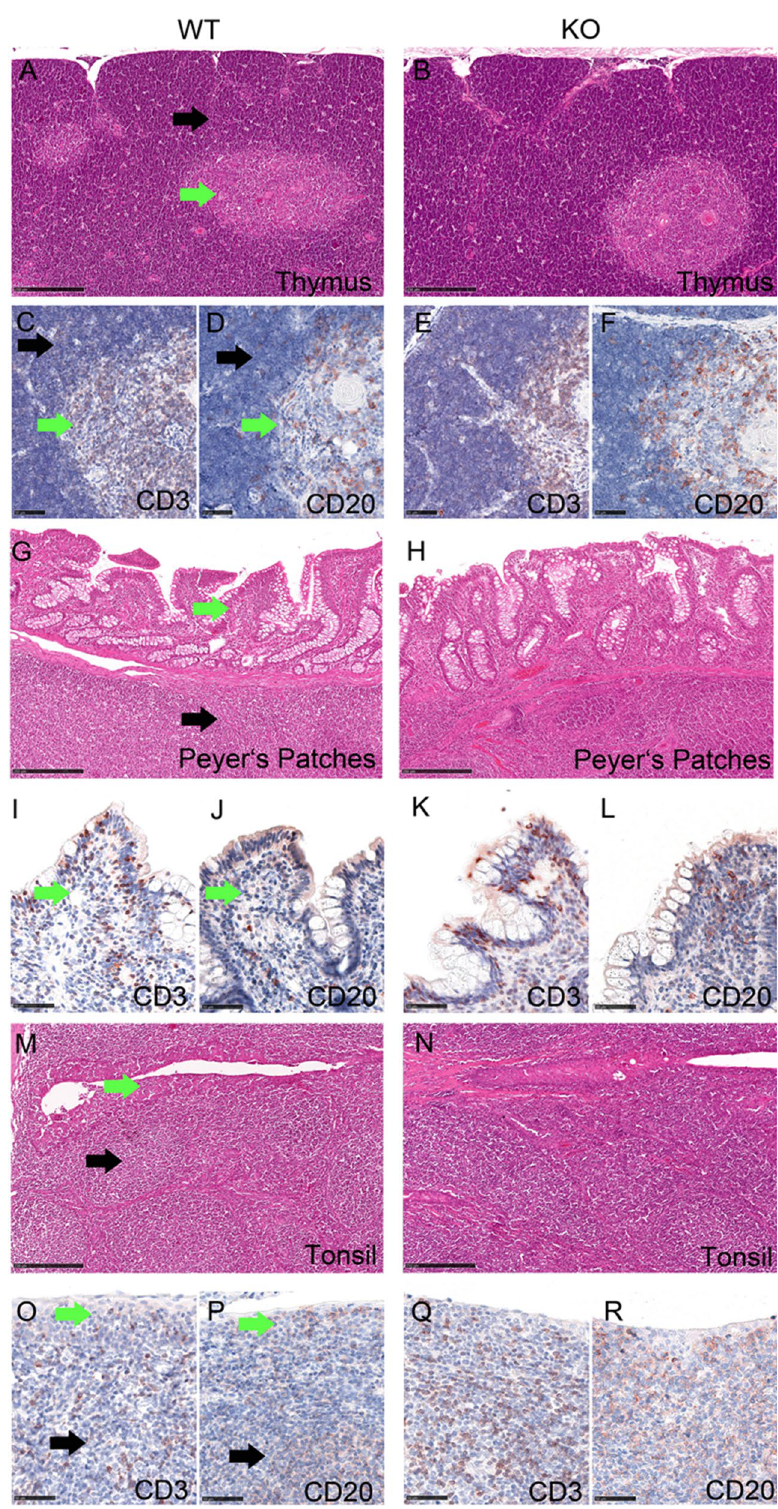
Figure 8. No differences between wildtype and TRDC-knockout pigs were detected by histological examination of lymphoid tissues. Lymphoid tissues from wild type (WT: A , C , D , G , I , J , M , O , P ) and knockout (KO: B , E , F , H , K , L , N , Q , R ) domestic pigs. Thymus ( A , B ) with cortex (black arrow) and medulla (green arrow), Peyer’s Patches ( G , H ) with mucosa associated lymphoid follicle (black arrow) and absorptive epithelium (green arrow) containing intraepithelial, and transmigrating lymphocytes, Tonsil ( M , N ) with mucosa associated lymphoid follicle (black arrow) and mucosal epithelium (green arrow) containing intraepithelial and transmigrating lymphocytes. H&E stain ( A , B , G , H , M , N ), immunohistochemistry ( C – F , I – L , O – R ), using anti-CD3 or anti-CD20 antibody as indicated, ABC method, AEC chromogen (red-brown), hematoxylin counterstain,